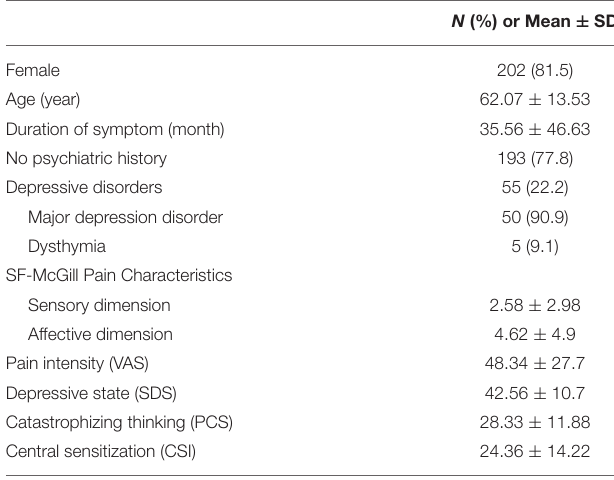
TABLE 1 | Demographic characteristics and symptom-related parameters of 248 BMS